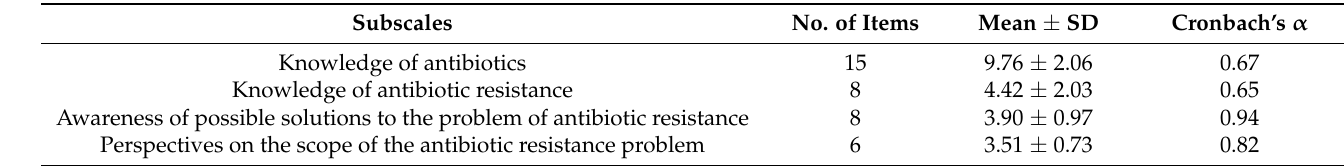
Table 7. Internal consistency of main